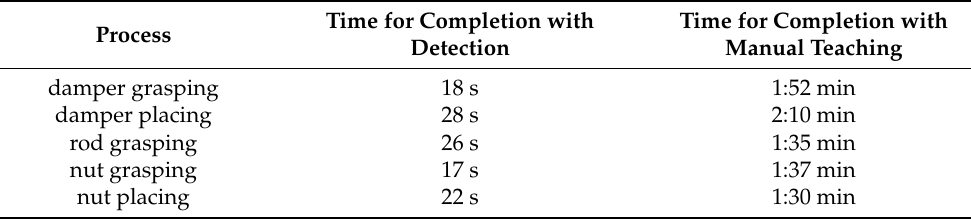
Table 3. Time of completion for pick-and-place processes with and without detection . Process